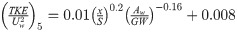
a) Schematic of the main length scales (δ* = x/S and Aw/GW) used in the non-dimensional model. b) Relationship between the non-dimensional number (TKE/Uw2)5 and (x/S)α(Aw/GW)β. The distance x is the closest distance to the nearest canopy boundary. The fitting follows the equation (TKEUw2)5=0.01(xS)0.2(AwGW)−0.16+0.008, with R2 = 0.7474, n = 24 and 99% of confidence.